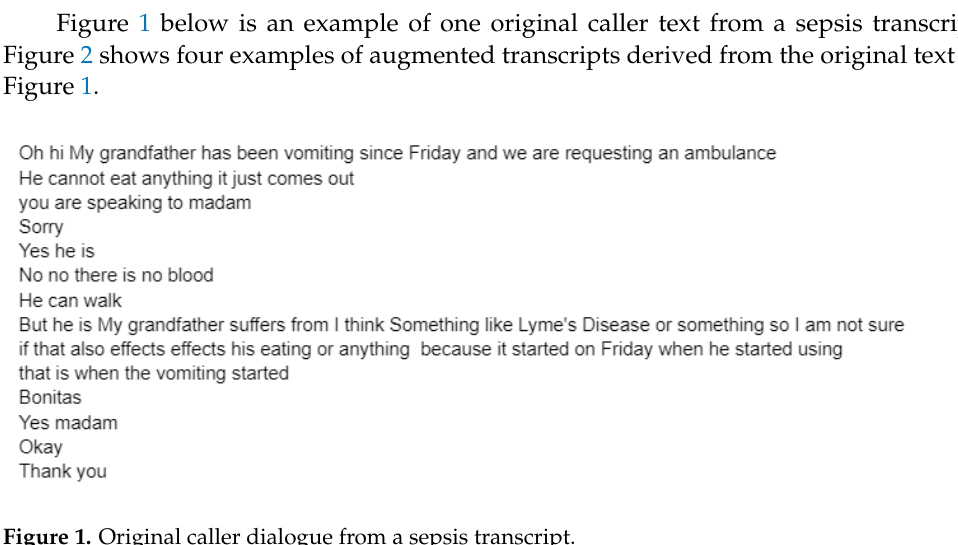
Figure 1. Original caller dialogue from a sepsis transcript. Figure 2 below is an example of four out of sixteen augmented transcripts derived from the original transcript in Figure